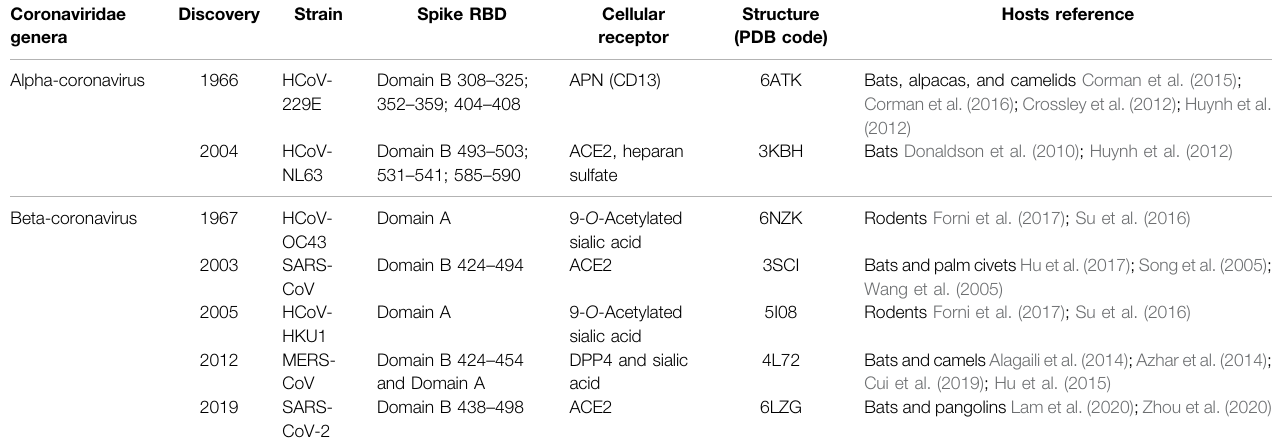
TABLE 1 | Classi fi cation of human